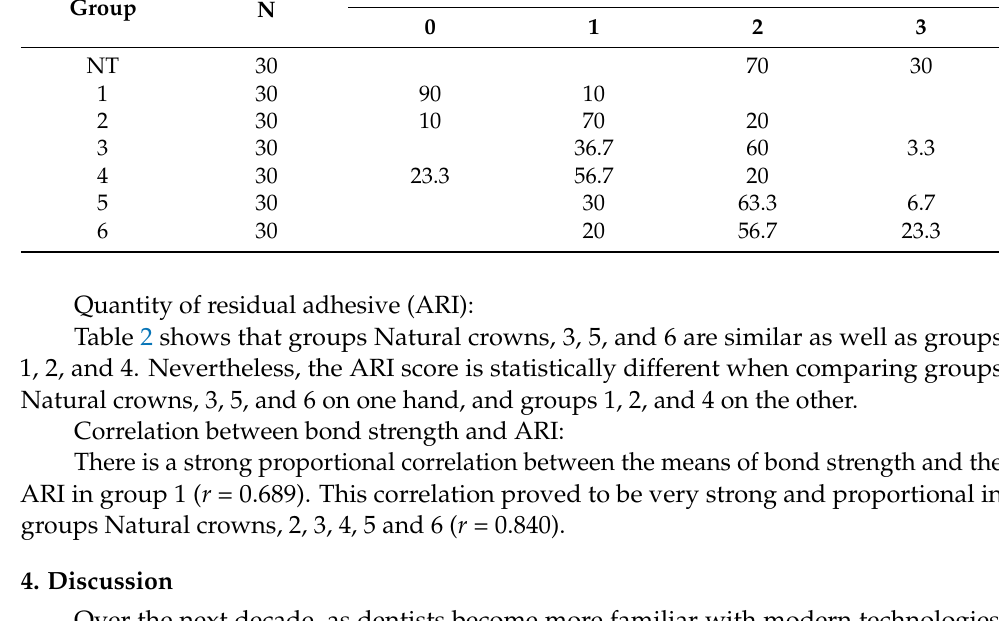
Scores of the Quantity of Residual Adhesive (ARI), % 0